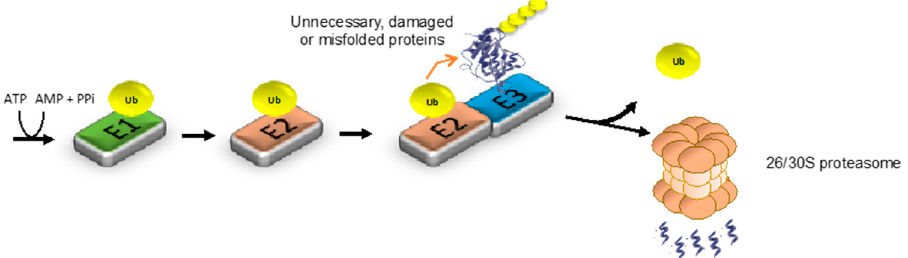
Figure 4. The ubiquitin-proteasome system (UPS). Unnecessary, damaged and misfolded proteins are marked for proteasomal degradation by the attachment of ubiquitin molecules via a three-step sequential mechanism. In the first step, ubiquitin is activated in an ATP-dependent manner by the ubiquitin-activating enzyme (E1). Then, activated ubiquitin is transferred to ubiquitin conjugating enzymes (E2s) forming E2-ubiquitin thioester structures. Finally, E3 ligases catalyze the attachment of ubiquitin to their specific substrate by binding both the E2-ubiquitin thioester structure and the target protein. The same cascade ubiquitination mechanism links additional molecules to the primary ubiquitin through internal ubiquitin lysines, forming a polyubiquitin chain. A chain of at least four lysine 48-linked ubiquitins is considered the primary signal for proteasomal degradation. E3 enzymes confer specificity to the UPS. Accordingly, more than 600 E3 ligases have been identified in humans so far. After the polyubiquitination cascade process, target substrates are recognized and degraded by the 26S/30S proteasome.